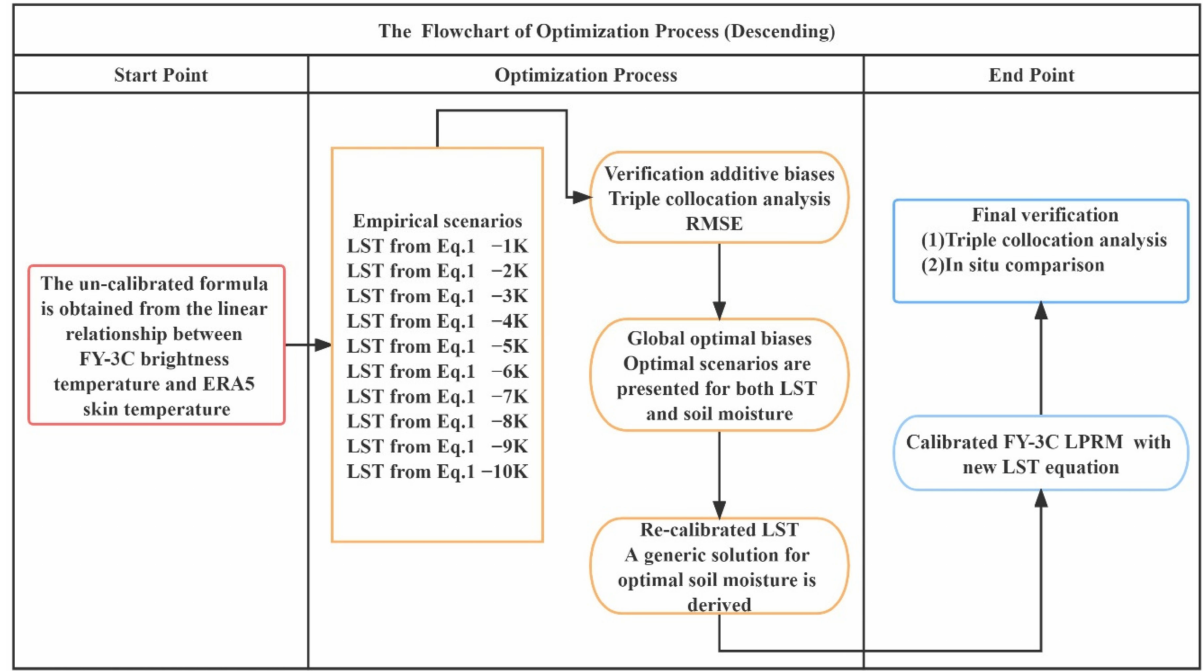
Figure 1. A flowchart that sequentially describes the multi-step optimization procedure for FY-3C descending LST. This procedure starts with the un-calibrated formula, followed by the additive bias scenarios used within the LPRM to obtain the calibrated LST equation. The flowchart for the ascending data is provided in the Supplementary